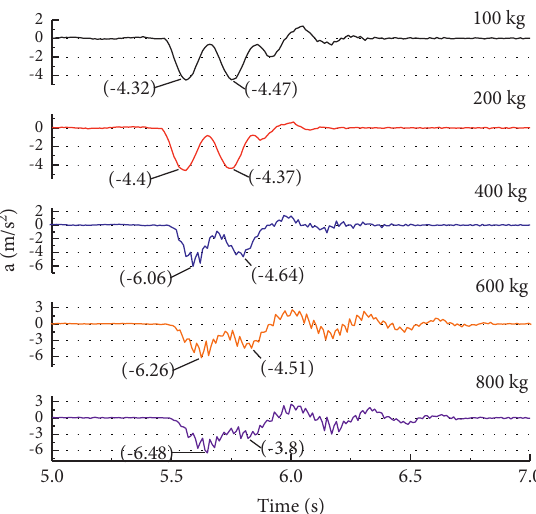
Figure 7: Longitudinal vibration of the frame during the upward emergency stop.